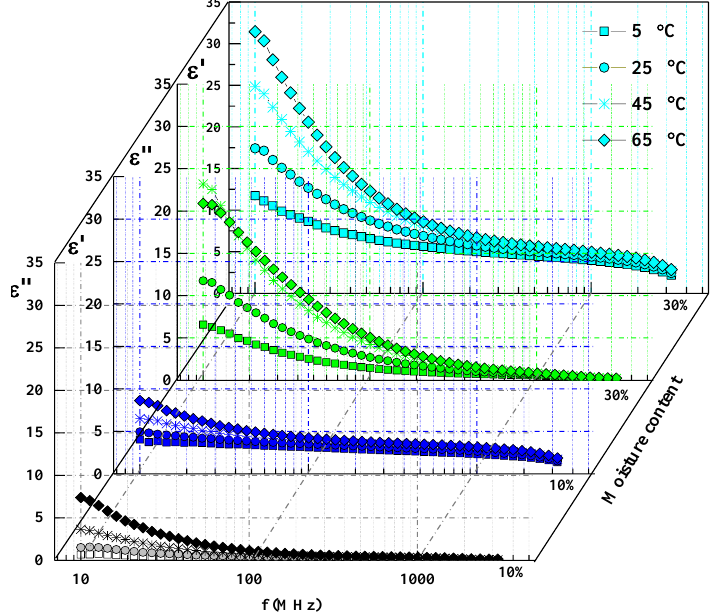
Figure 1. Frequency-dependent dielectric constant ( ε ’) and loss factor ( ε ”) of the pecan kernels at four temperatures and moisture contents of 10% and 30%.